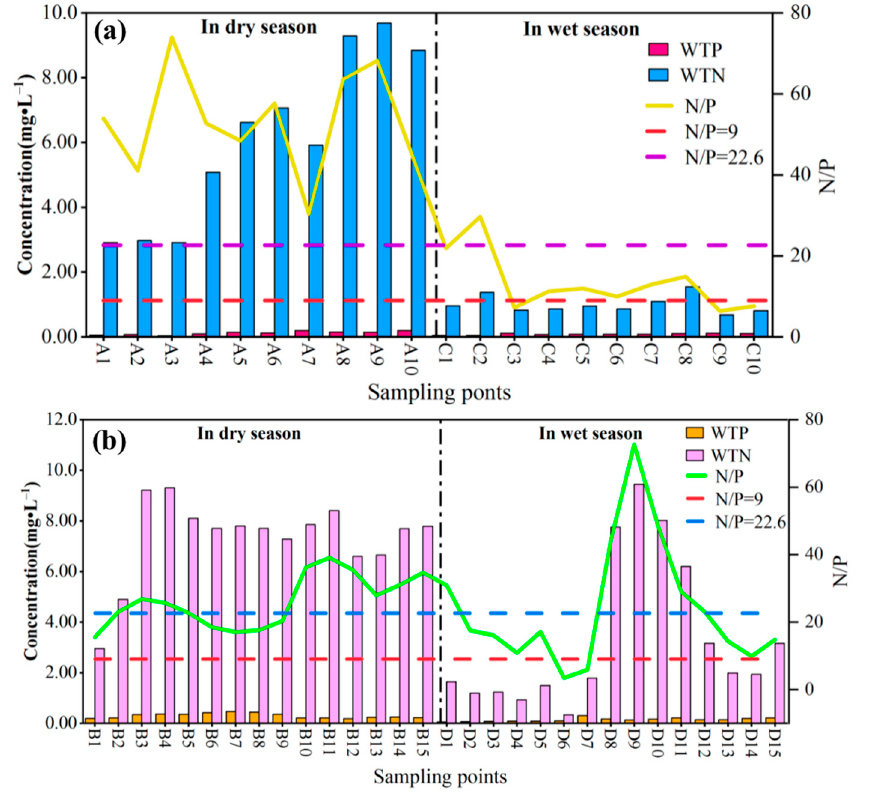
Figure 9. The ratio of N to P (N/P) in the study area (( a ): Pi river, ( b ): Shiting river).